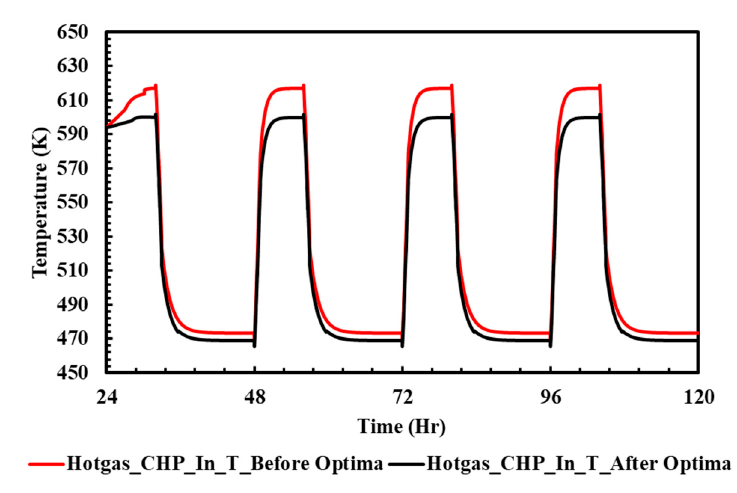
Figure 8. Temperature variation of the exhaust gases in the non-modified and optimal control cases.